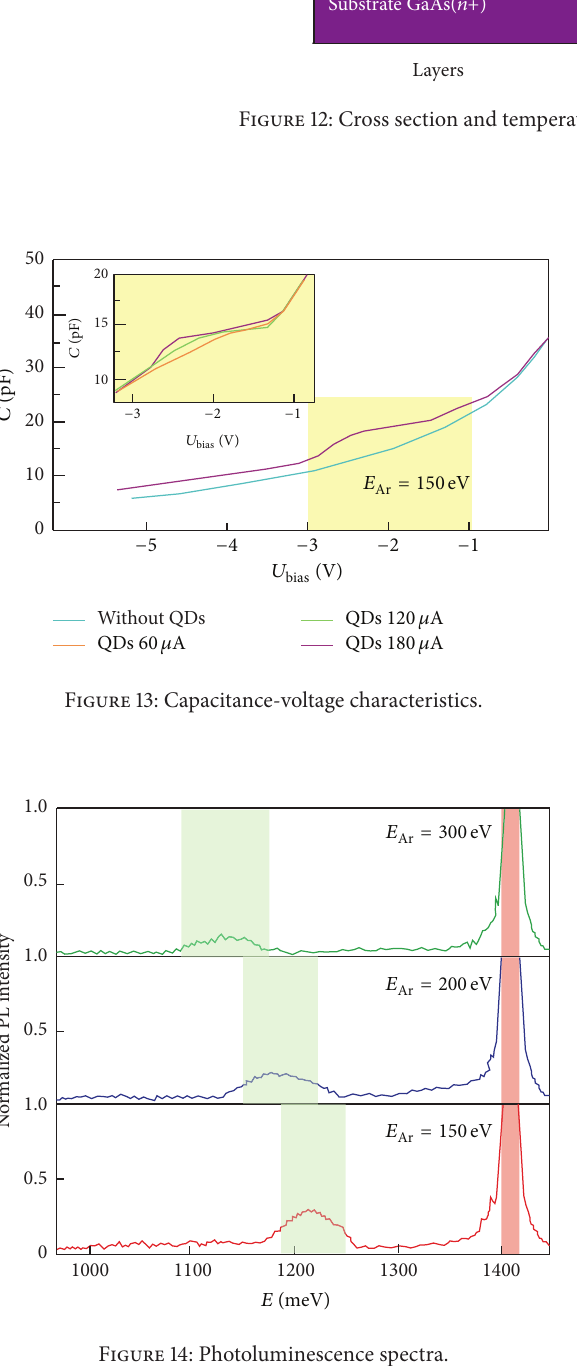
Figure 14: Photoluminescence